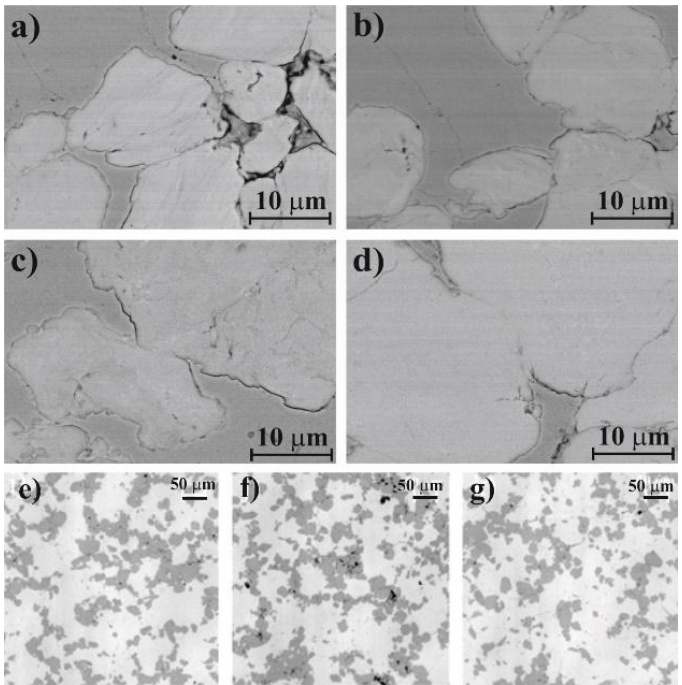
Figure 6. Microstructure of composites ball-milled with a ball-to-powder ratio of 80:1, ( a – c ) Cu 39.2 Zr 36 Al 4.8 Ni 10 Ti 10 ( a ) 5 min (BM4); ( b ) 10 min (BM5); ( c ) 15 min (BM6); ( d ) 15 min Cu 39.2 Zr 35.2 Al 5.6 Ni 10 Ti 10 (BM9); ( e ) 5 min (BM6); ( f ) 10 min (BM6); ( g ) 15 min (BM6).